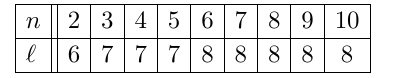
Table 8: Value of ‘ as a function of n with ∆ = 0 . 02 for Kyber and Saber